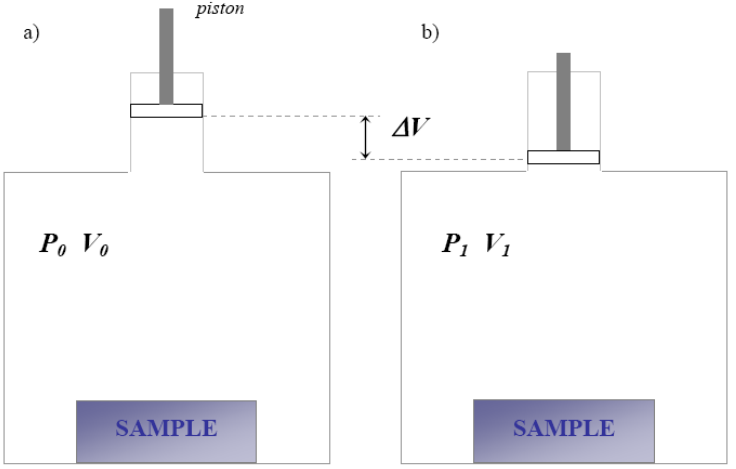
Figure 4. Schematic diagrams of the porosity measurement system based on the air volume compression method: ( a ) before the compression, ( b ) after the compression of know volume ∆ V [26].